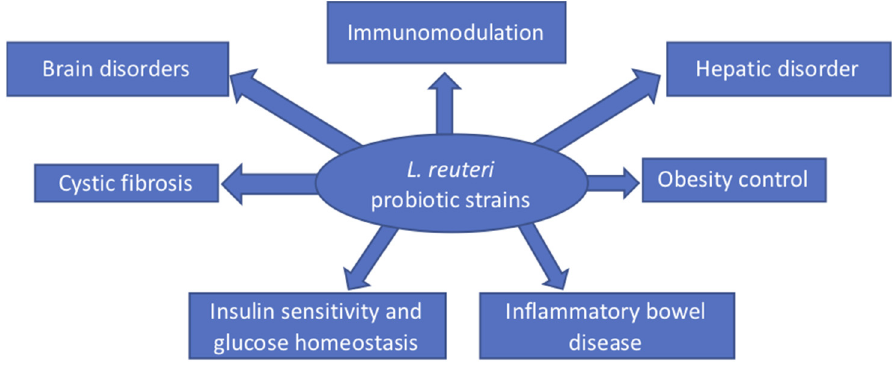
Figure 1. Involvement of L. reuteri in different human pathological conditions.